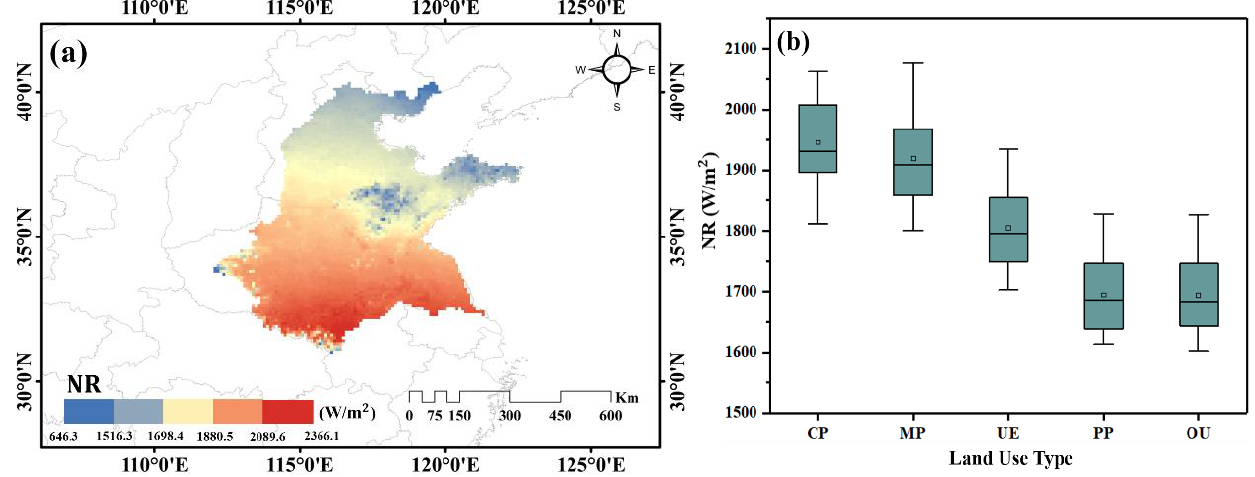
Figure 6. ( a ) Spatial variation in net radiation (NR) in the Huang-Huai-Hai River Basin for 2000–2015 and ( b ) statistical values for the five use types.